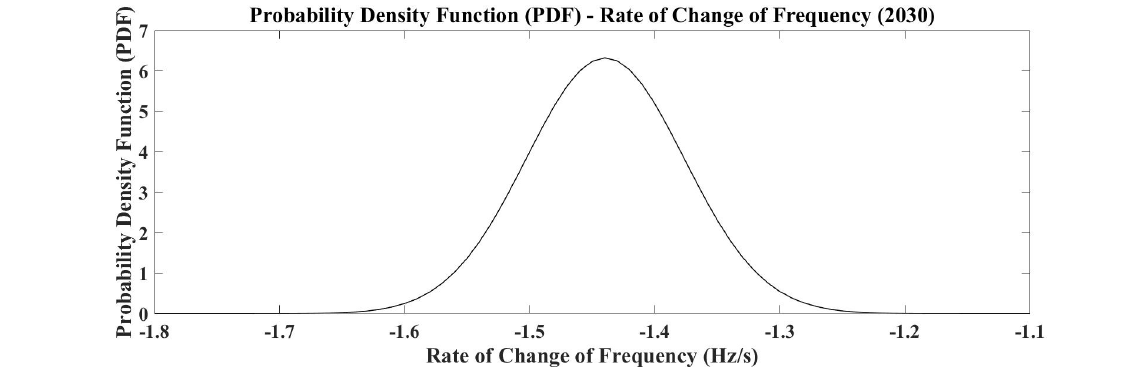
Figure 9: PDF curve of minimum frequency for year 2030.